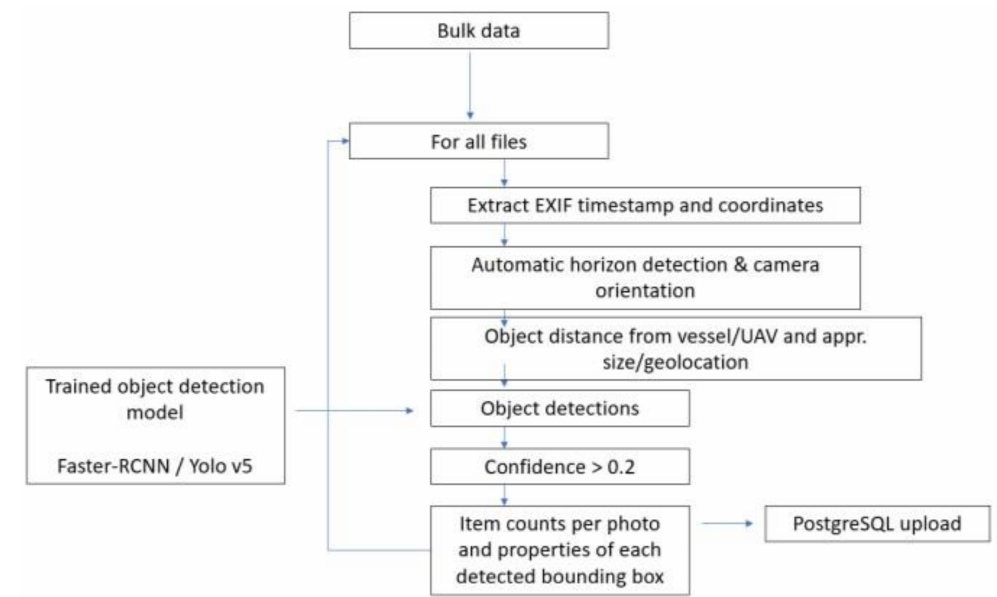
Figure 4. The automated part of the processing